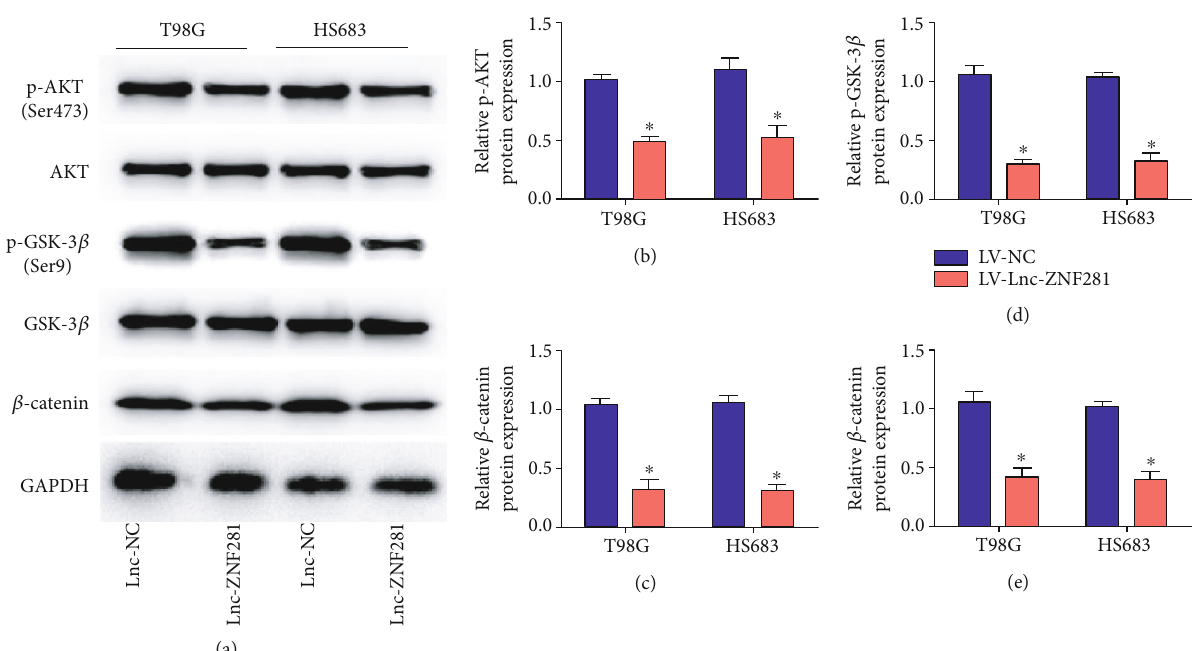
Figure 5: Overexpression of lnc-ZNF281 inhibited the AKT/GSK-3 β / β -catenin pathway in glioma cells. (a – c) The Western blot results showed that overexpression of lnc-ZNF281 decreased the protein expression levels of p-AKT and p-GSK-3 β , while had no e ff ect on total AKT and GSK-3 β protein levels. (d, e) Results of Western blot and qPCR demonstrated that increased lnc-ZNF281 suppressed the expression of β -catenin mRNA and protein. ∗ p < 0 : 05